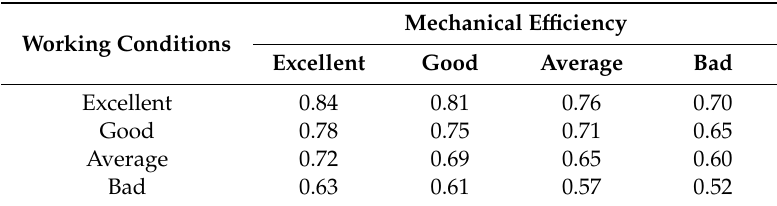
Table 1. Maximum e ffi ciency